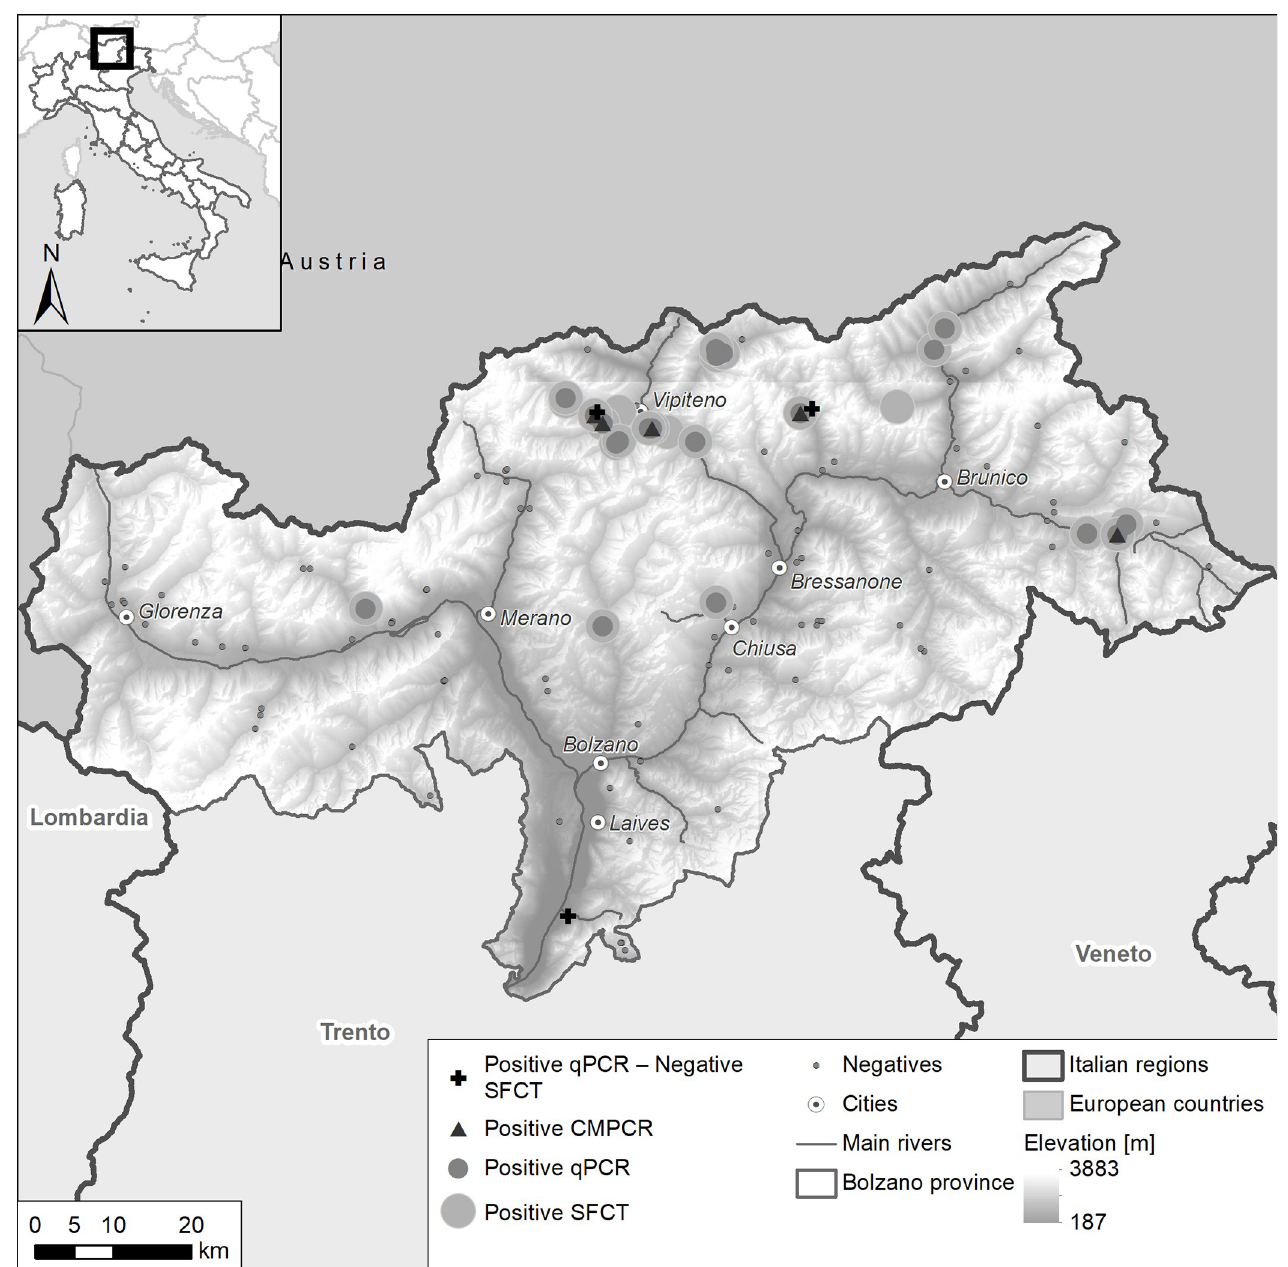
Fig 2. Results of CMPCR, qPCR and the SFCT- reference standard used to detect Echinococcus multilocularis in fox faecal samples collected in 2019– 2020 (n = 123). The DEM used as baselayer is provided by TINITALY. The data are available under license CC BY 4.0. https://doi.org/10.1371/journal.pone.0268045.g002 Based on the Se and Sp calculated from these results (Table 2), the TP estimated for the whole sample set (n = 235) was 14.3% (CI95%: 0–29.14) for CMPCR and 14.2% (CI95%: 7.04– 22.64) for qPCR. The sample size required for the detection of E . multilocularis in a fox popula- tion of 300 individuals with various expected prevalence values is shown in Fig 3. Regression was obtained by interpolating 13 prevalence values. For example, if the expected prevalence is 15%, about 90 individuals (about 30% of the population) should be tested when using